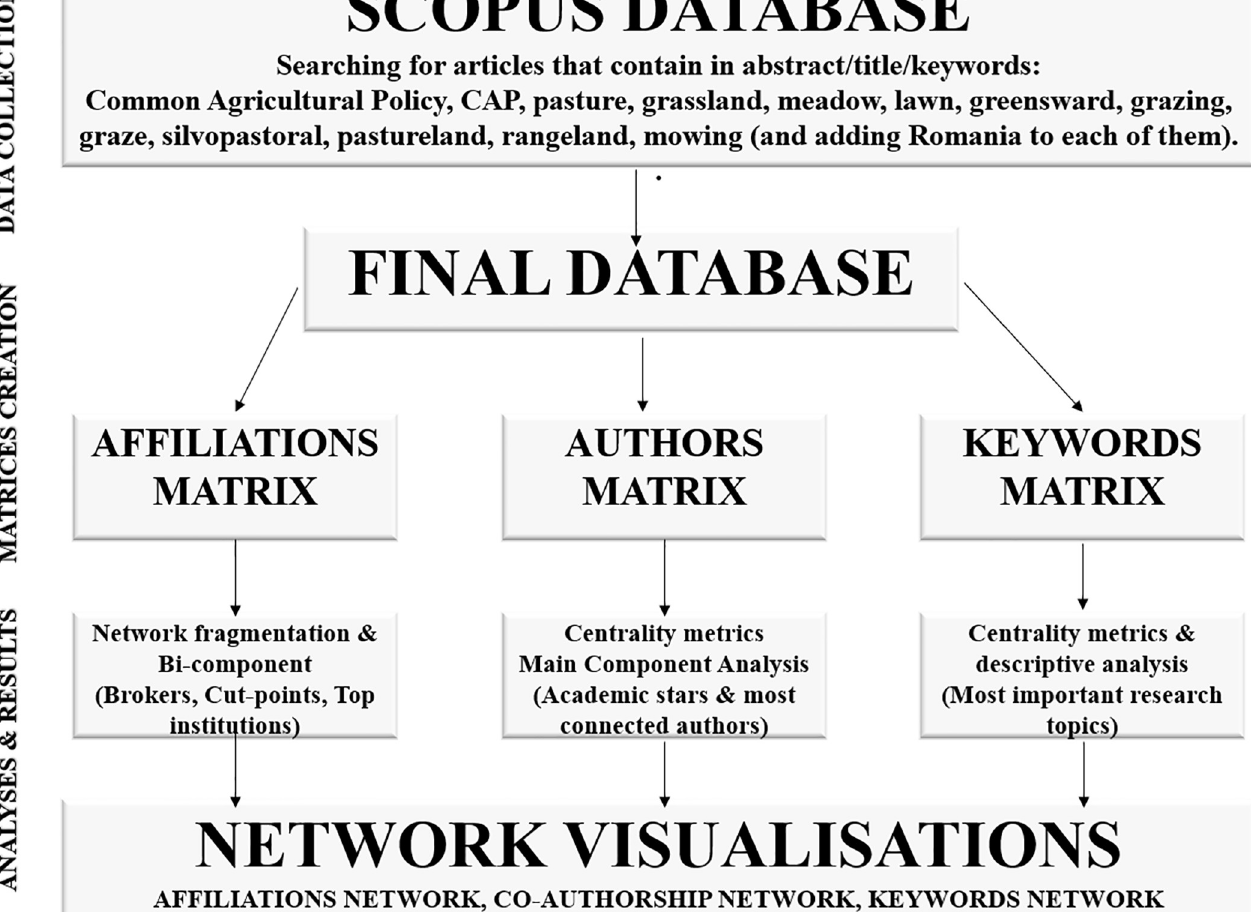
Fig 2. Workflow of network analyses of internationally visible research related to grasslands in